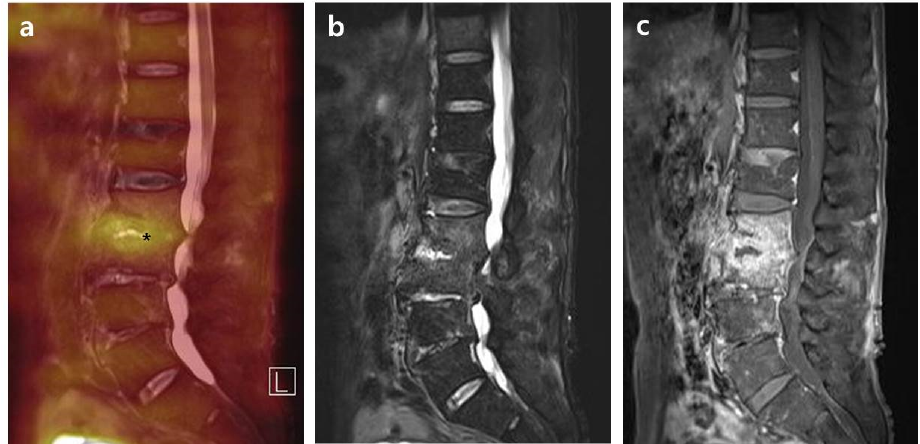
Figure 1. Simultaneous FDG-PET/MRI with the location of SUV max on the intervertebral structure after successful antimicrobial therapy. A 78-year-old male patient shows PVO of L2–3 on simultaneous FDG-PET/MRI with SUV max 3.17 on the intervertebral structure (asterisk) after 30 days of vancomycin (CRP 1.70 mg/dL). In the distribution pattern of the PVO lesion, FDG uptake on FDG-PET ( a ) and high signal intensity on T2FS ( b ) are limited on the destroyed disc and endplates rather than the bone and soft tissue. However, T1C shows significantly increased enhancements on the overall PVO lesion ( c ). FDG-PET/MRI, 18 F-fluorodeoxyglucose positron emission tomography/magnetic resonance imaging; SUV max , maximum standardized 18 F-fluorodeoxyglucose uptake value; PVO, pyogenic vertebral osteomyelitis; CRP, C-reactive protein; T2FS, T2-weighted fat saturation magnetic resonance imaging; TIC, T1-weighted contrast magnetic resonance imaging.